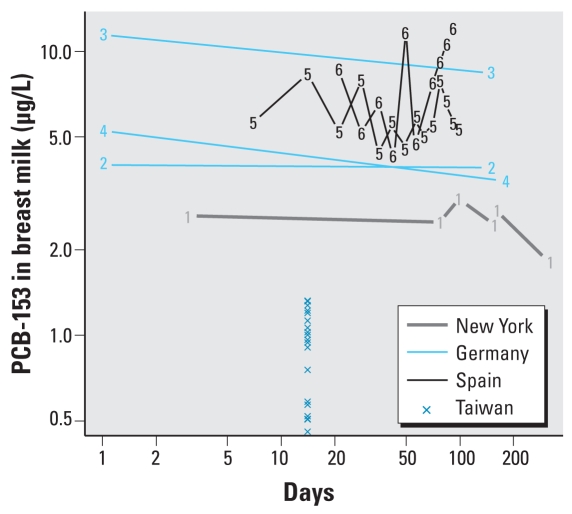
Time courses of PCB-153 concentrations in milk from lactating mothers from various countries. New York State data are from Schecter et al. (1998); each number 1 indicates the milk concentration value and time of sampling for six lactating women. Data for Germany are from Abraham et al. (1998), and the numbers 2, 3, and 4 represent time course data from three lactating women. Data for Spain are from Ramos et al. (1997), and numbers 5 and 6 indicate time course data for two lactating women. Xs represent single data points for 20 lactating women in Taizhong hospital in Taiwan.